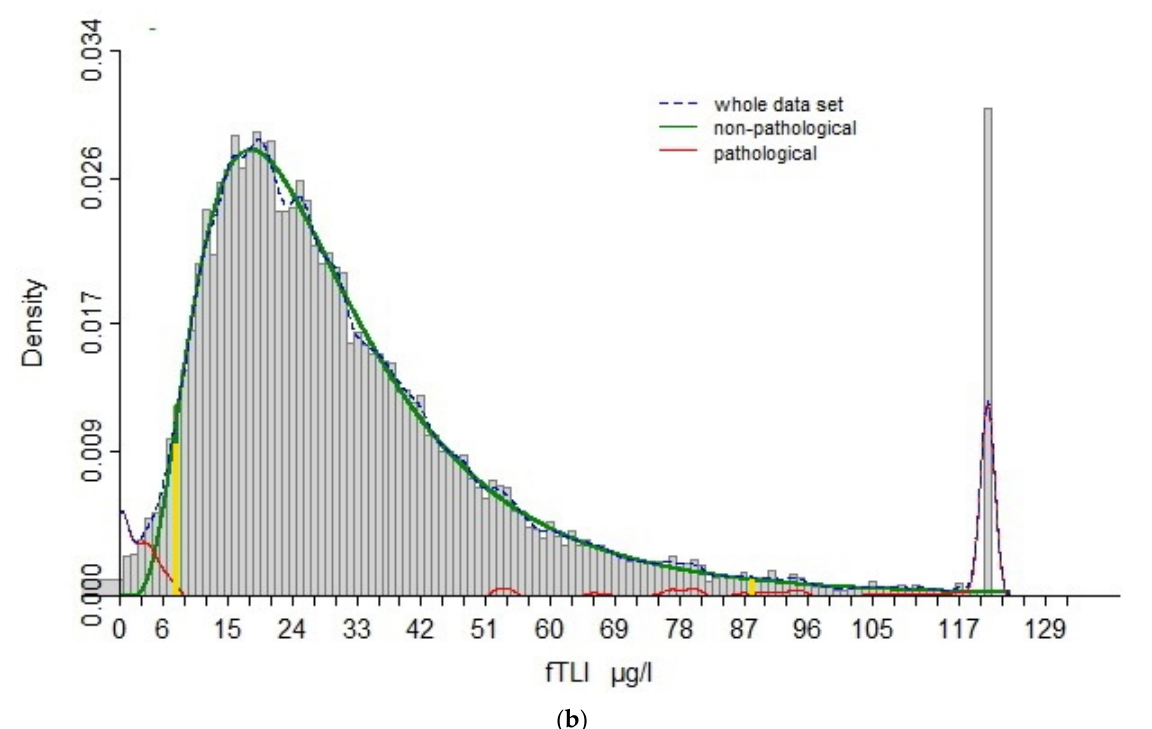
Figure 1. Feline trypsin-like immunoreactivity interval based on ( a ): 4813 cats (2019–2020) and ( b ): 21,714 cats (2017–2020), calculated using the Reference Limit Estimator with an algorithm to exclude presumably non-healthy individuals by decreasing the statistical error based on a high number of data sets. The x -axis represents the serum fTLI concentrations and the y -axis gives the density/frequency of the values. The dotted blue line represents all data sets. This is further divided mathematically into non-pathological (green line) and pathological (red line) values. The vertical yellow lines represent the 2.5 ( a : 7 µg/L, b : 8 µg/L) and 97.5 ( a : 89 µg/L, b : 88 µg/L) percentiles of the estimated distribution for non-pathological values. As it is a mathematical formula/algorithm, little overlap is expected in both directions, with few non-pathological serum fTLI concentrations within the estimated reference limits, and few pathological ones below or above the reference limits.